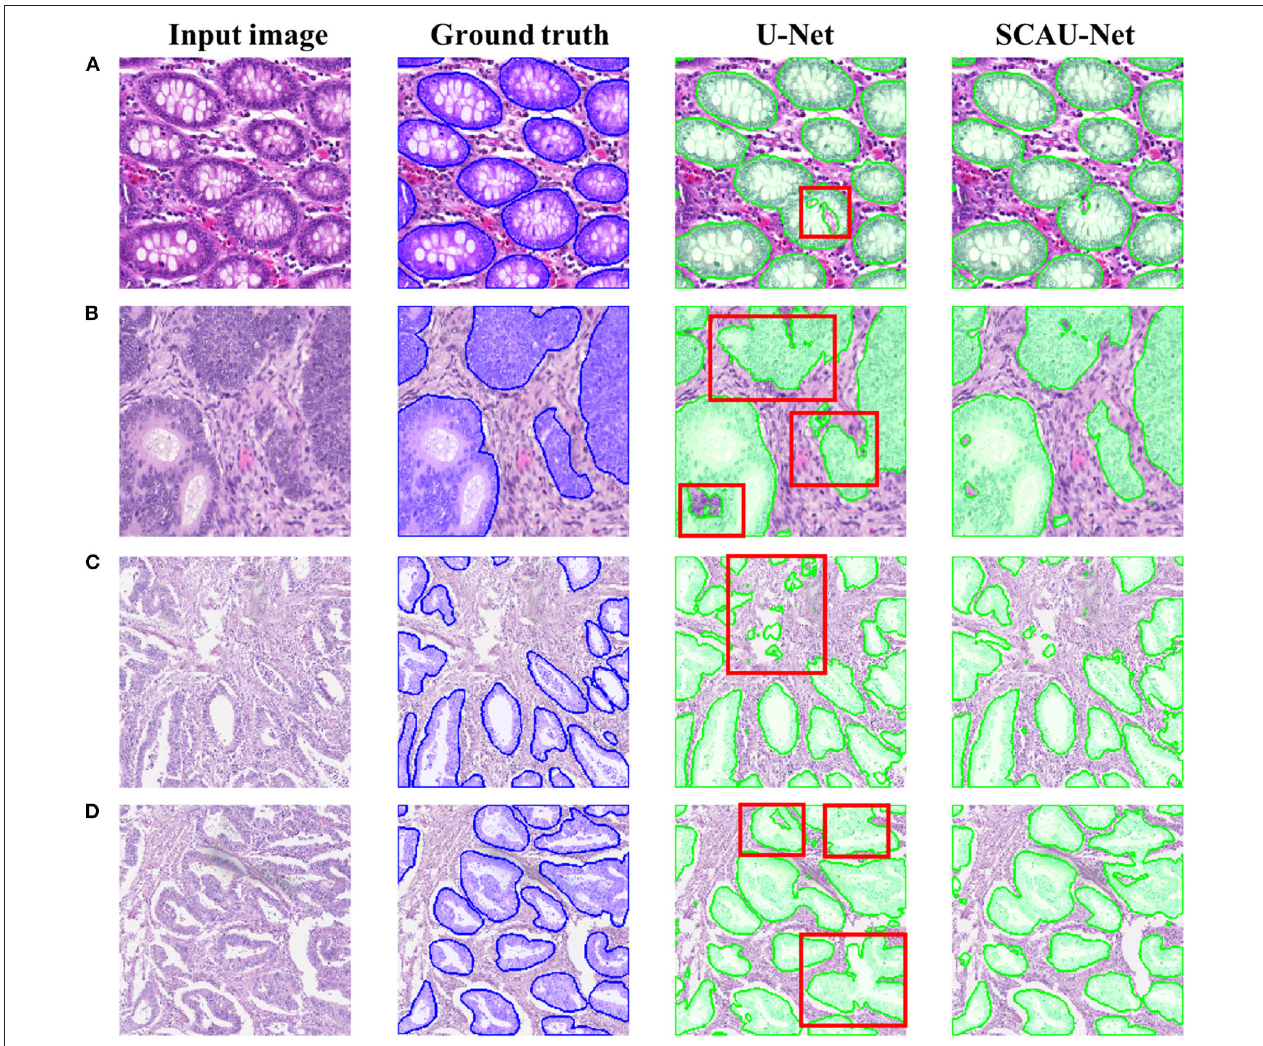
FIGURE 5 | Comparison of segmentation results. Examples (A,B) are from the GlaS dataset, and examples (C,D) are from the CRAG dataset. The red boxes indicate areas with poor segmentation